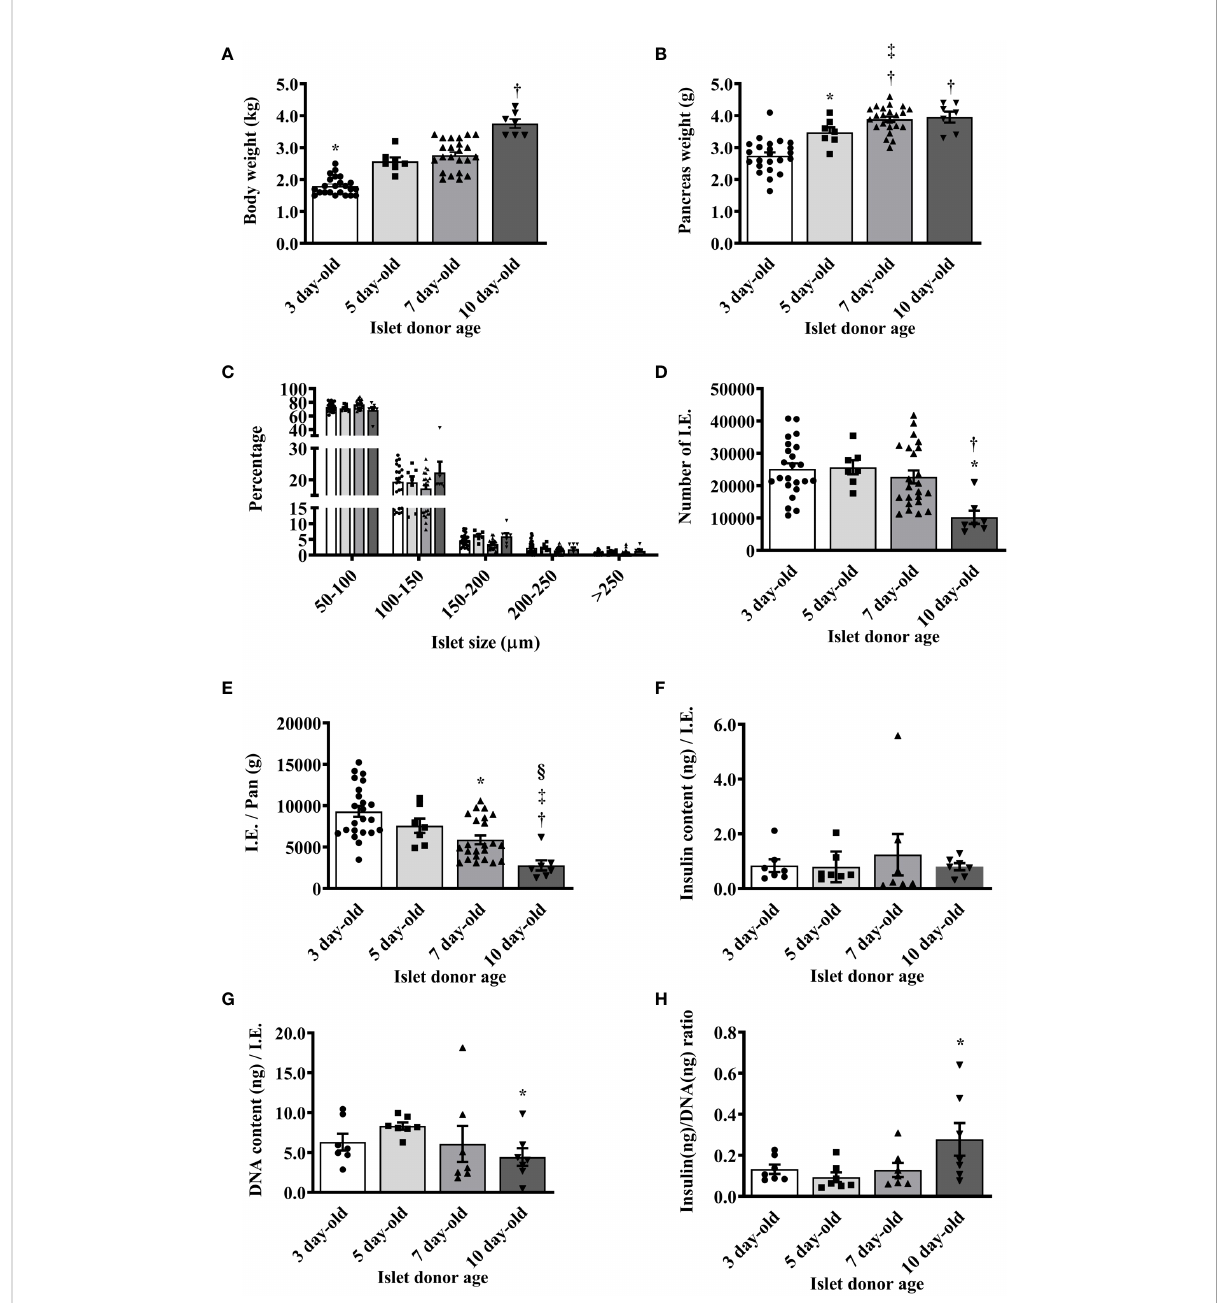
FIGURE 1 Morphological characteristics of islets isolated from neonatal pigs of various ages. (A) Mean body weight of neonatal pigs (*p <0.0001, 3-day-old vs. 5-, 7-, and 10-day-old; † p <0.0001, 5- and 7-day-old vs. 10-day-old). (B) Mean pancreas weight of neonatal pigs (*p <0.005 between 3- and 5-day-old; † p <0.0001, 3-day-old vs. 7- and 10-day-old; ‡ p <0.05 between 5- and 7-day-old). (C) Proportions of islets isolated from various ages of neonatal pigs based on size. (D) Islet yield expressed in I.E. (*p <0.0005, 3- and 5-day-old vs. 10-day-old; † p <0.005 between 7- and 10-day-old). (E) Islet yield per pancreas weight of neonatal pigs (*p <0.0005 between 3- and 7-day-old; † p <0.0001 between 3- and 10-day-old; ‡ p <0.001 between 5- and 10-day- old; §p ≤ 0.005 between 7- and 10-day-old). Data from 3- (n=23), 5- (n=7), 7- (n=23), and 10- (n=7) day-old pigs are shown. (F) Insulin content per I.E. from various ages of neonatal pigs. (G) DNA content per I.E. from various ages of neonatal pigs (*p <0.01 between 5-day-old vs. 10-day-old). (H) Insulin to DNA content ratio detected in islets from various ages of neonatal pigs (*p <0.05 between 5- and 10-day-old). Data from 3-, 5-, 7-, and 10-day-old pigs (n=7 for each group) are